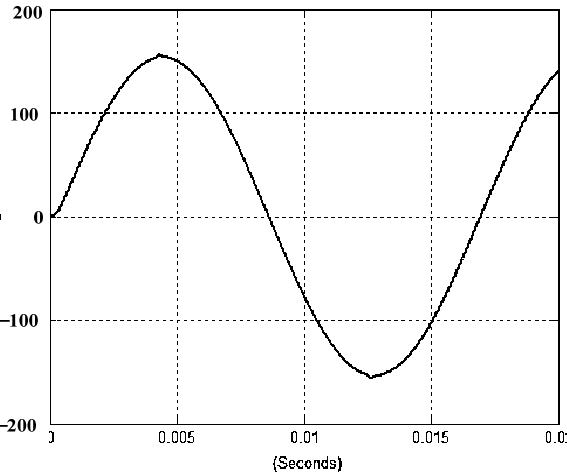
Figure 8. Simulated AC output voltage for the proposed method under a sudden removal of load.